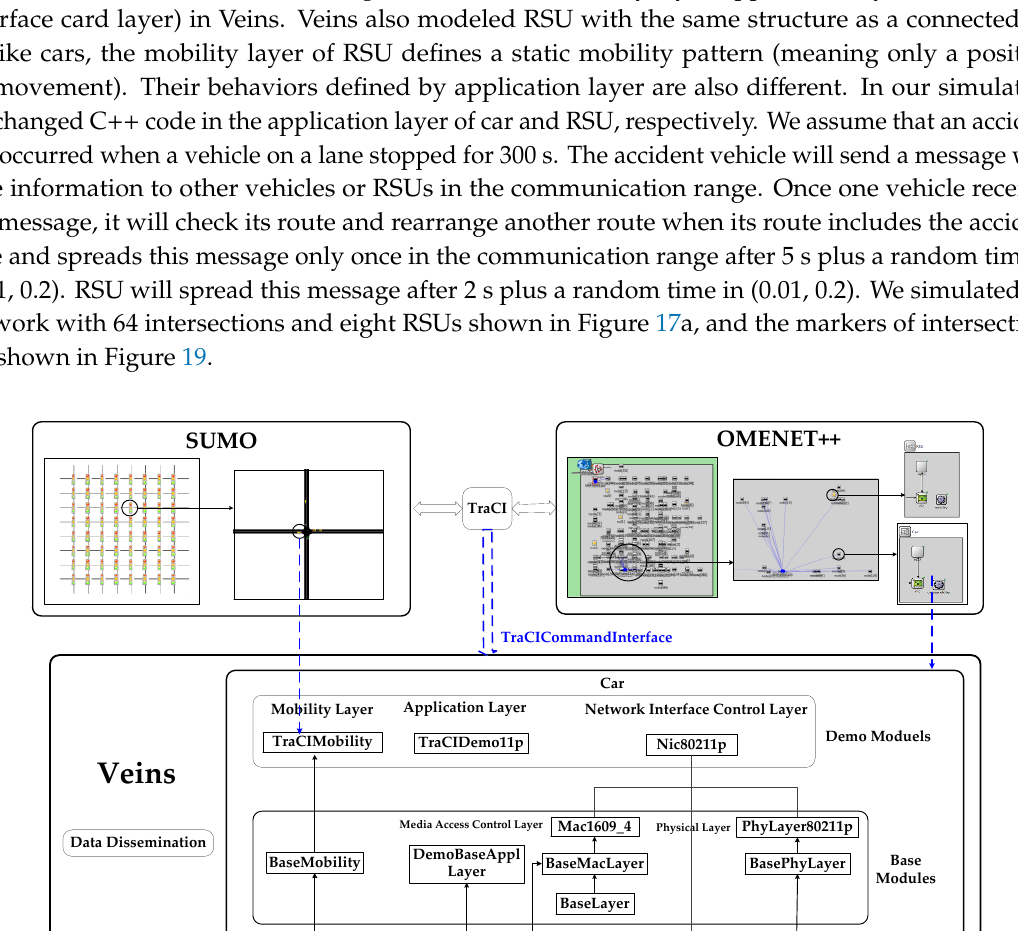
Figure 18. Framework of Vehicles in Network Simulation (Veins).